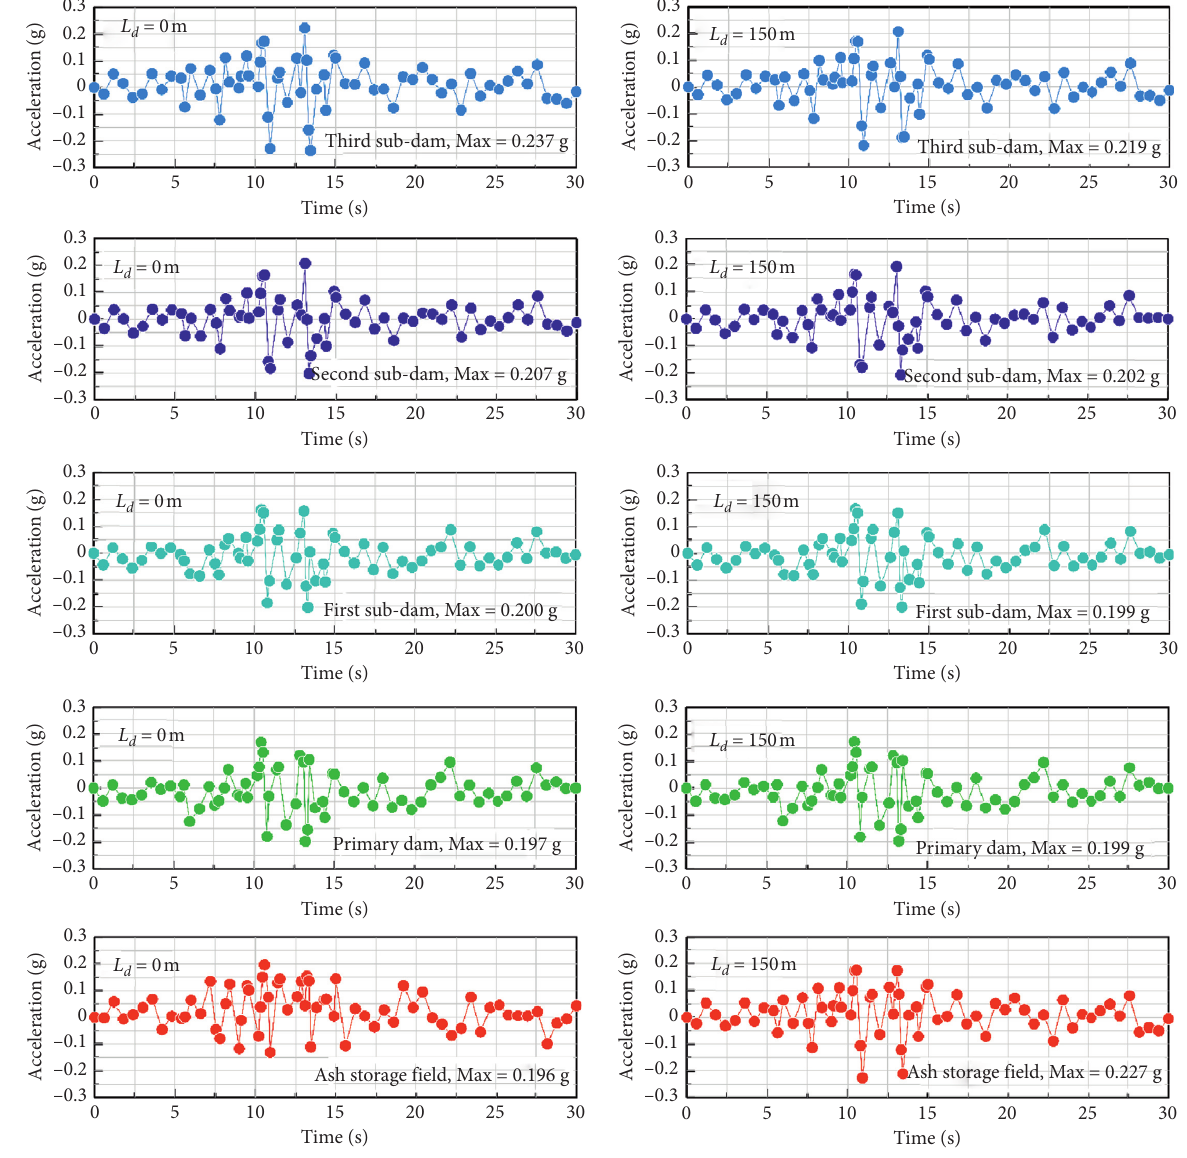
Figure 6: Time-course curves of acceleration of various parts of the ash storage